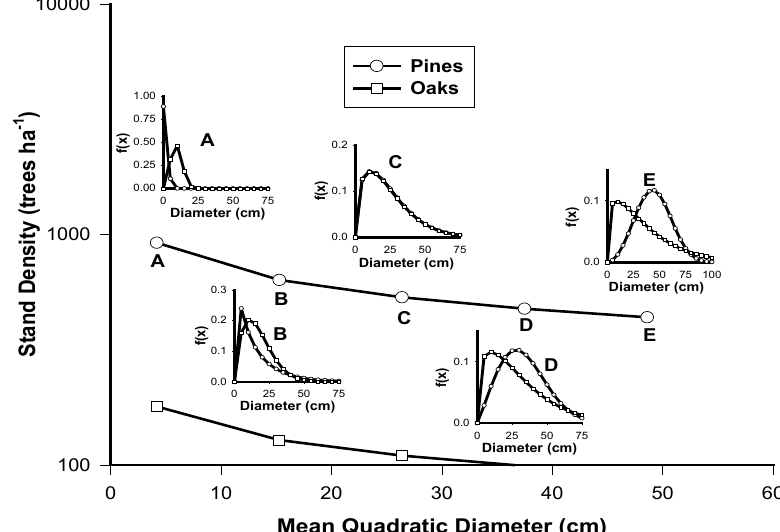
Figure 5. Graphical representation of the stand class growth and yield model for pines and oaks of Mexico’s northern mixed temperate forests. Capital letters indicate the sequence in mean quadratic